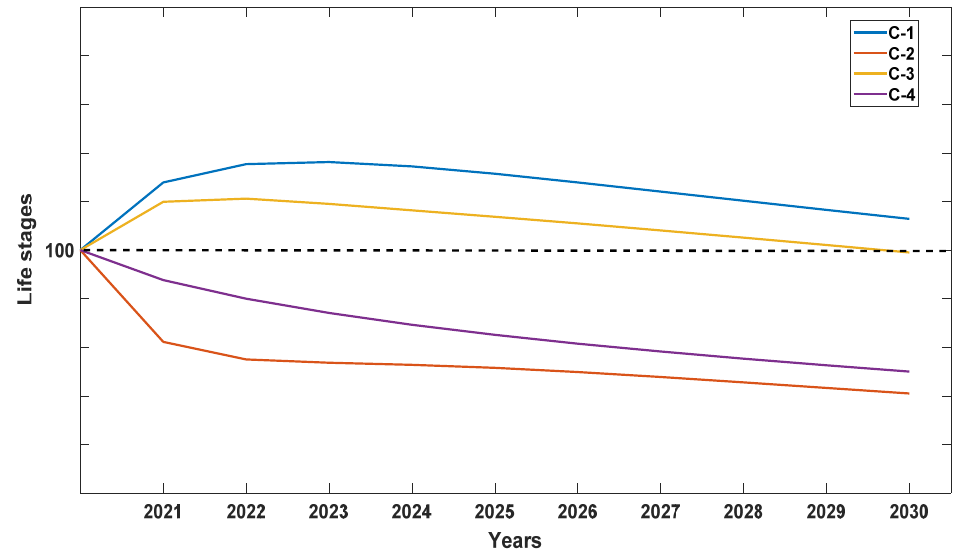
Figure 7. Projection of the behavior between the different orchid life stages (seedlings, juveniles, mature) for the next 10 years at Population A within the Florida Panther National Wildlife Refuge. Orchid life stages listed include seedlings (C-1), juveniles (C-2), smaller mature (C-3), and larger mature orchids (C-4). This graph shows that mature plants, like those in the other six populations, are in decline. These mature plants are the presumed source of the spontaneous seedlings observed in Population A. A drop in the number of mature plants would be expected to result in a drop in the number of spontaneous seedlings in the years ahead.